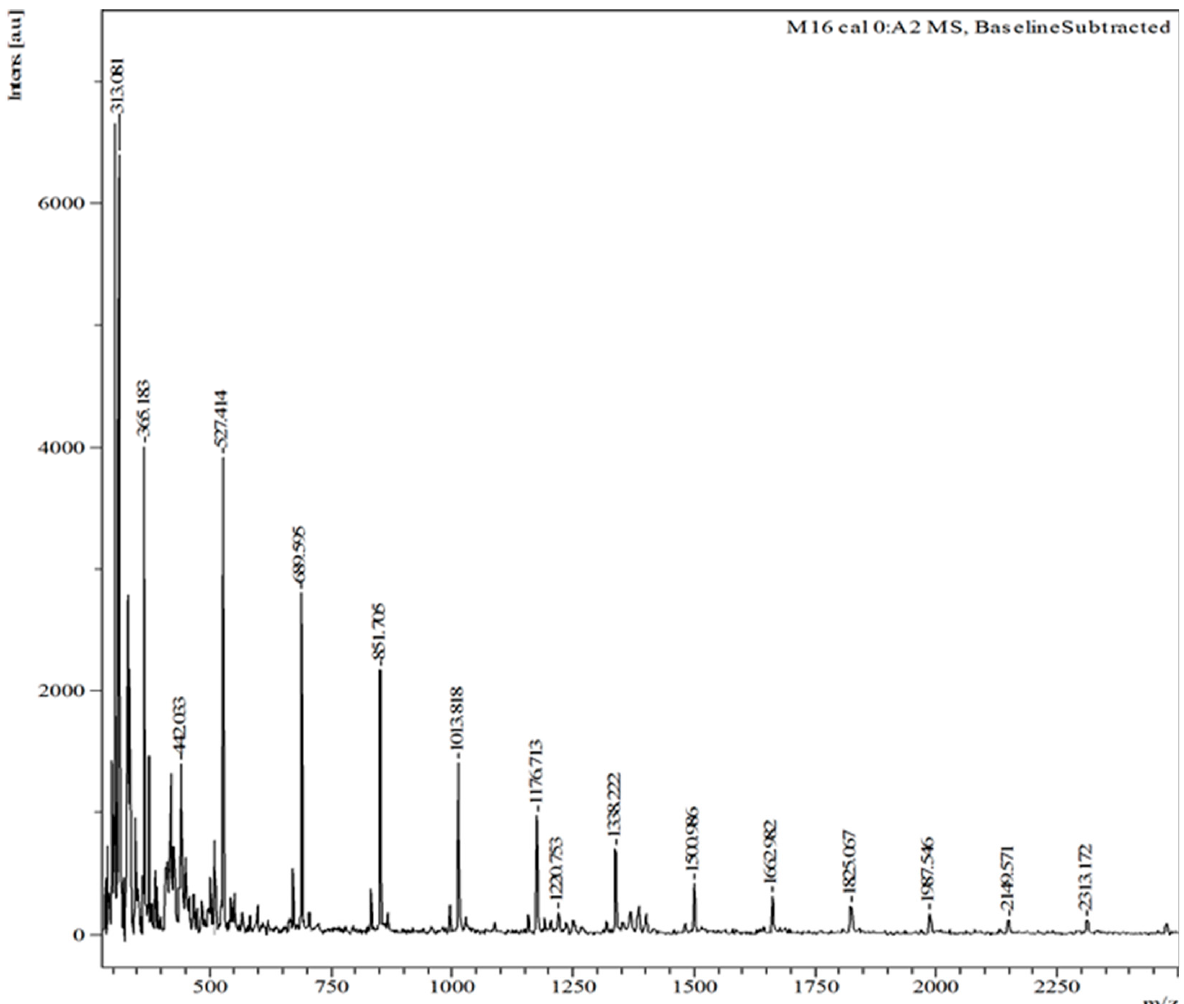
Figure 1. MALDI − TOF − MS profile of the FOS used in this study. Two kinds of agave fructan bioconjugates were prepared, with short-chain (propionate) and medium-chain (laurate) acyl groups. Both short- and medium-chain fatty acids have been described as beneficial for the colonic gut microbiota [26]. Indeed, the short-chain fatty acids (SCFAs) acetate, propionate, and butyrate are reported as important fuels for intestinal epithelial cells [6]. Regarding propionate, the results of Byrne et al. in nonobese men suggested that colonic propionate may play an important role in human appetitive and reward-based eating behavior [27]. Medium-chain fatty acids and triglycerides inges- tion results in ketone body production, provoking a thermogenic response [28]. Lauric acid showed insulinotropic effects in mouse models [29]. Thus, these fatty acids were investigated as acyl donors for agave fructan bioconjugates. as an example, Figure 2 shows the HPLC product profile of agave fructan bioconjugates synthesized with laurate. Fructans are not detected by the diode-array, and therefore, the visualized peaks are agave fructan bioconjugate products. Complete consumption of vinyl laurate (acyl donor) was observed. A similar behavior was detected with propionate agave fructan bioconjugates (data not